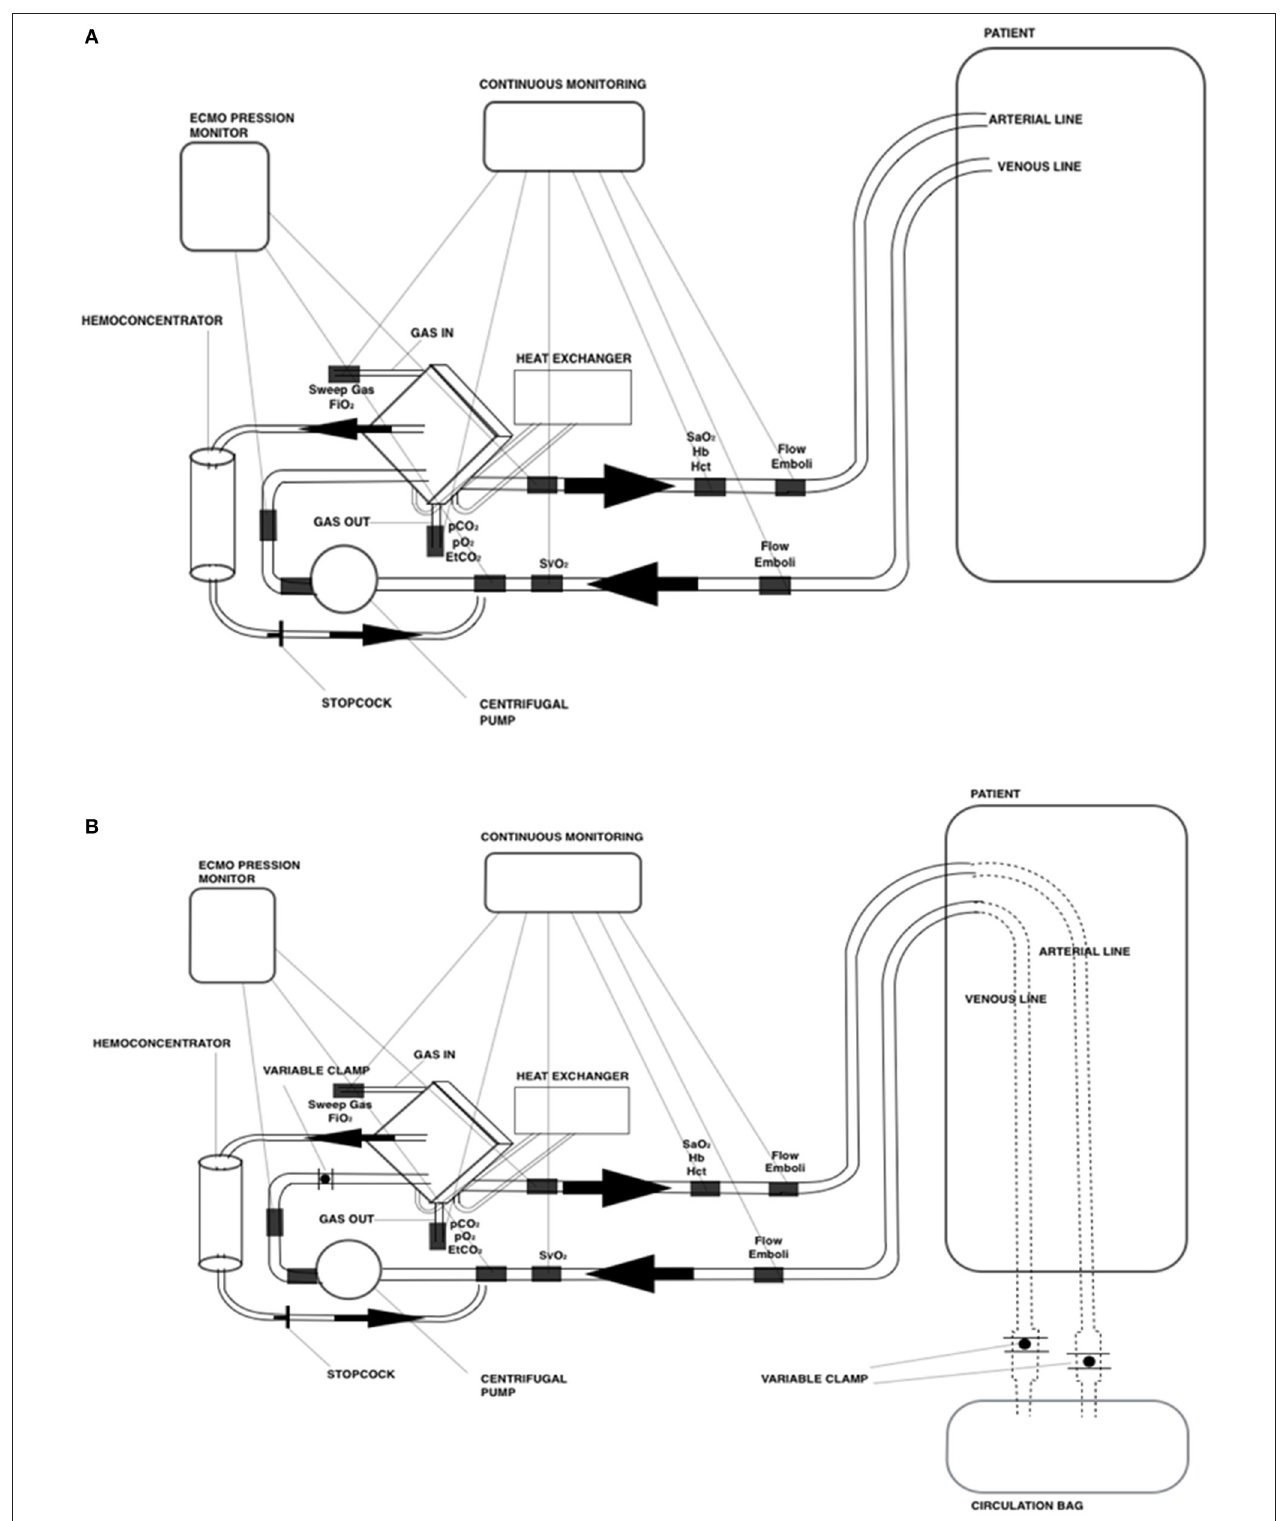
FIGURE 2 | Schematic drawing of the ECMO circuit used for (A) animal laboratory and (B) mannequin-based simulations.